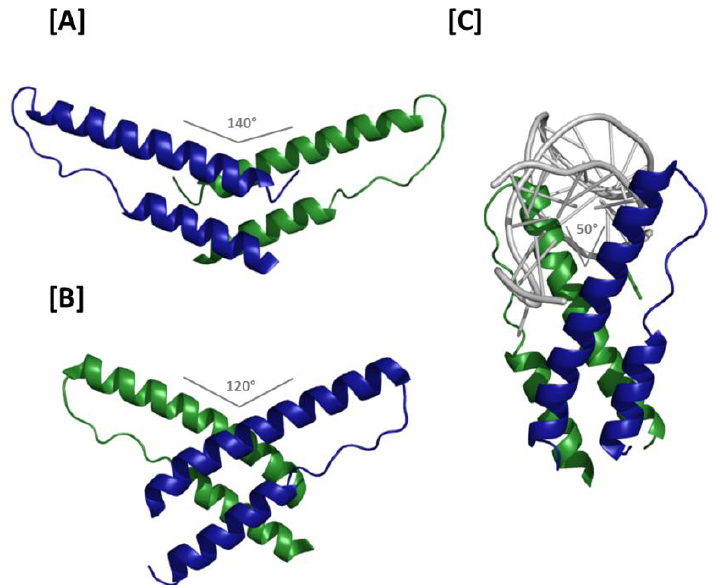
Figure 3. Crystal structures of Rev dimers: ( A ) Ribbon representation of the H/H Rev dimer. The angle formed by the two ARMs is 140 ◦ , which separates the apices of the two NLS/RBDs by approximately 8 nm and precludes binding at adjacent sites on an RNA helix; ( B ) T/T Rev dimer structure. In the absence of RNA, the ARM angle is 120 ◦ . Binding at adjacent RNA sites is conceivable, but higher order Rev multimerization would likely require a reduced ARM angle at H/H interfaces; ( C ) Structure of the T/T Rev dimer in complex with RNA. The two ARMs bind RNA at adjacent sites on the helix and are oriented at an angle of 50 ◦ relative to each other. The Rev oligomerization and RNA helical axes in this structure are roughly parallel, thereby facilitating consecutive binding and the higher order structures proposed in the jellyfish model of Rev assembly.